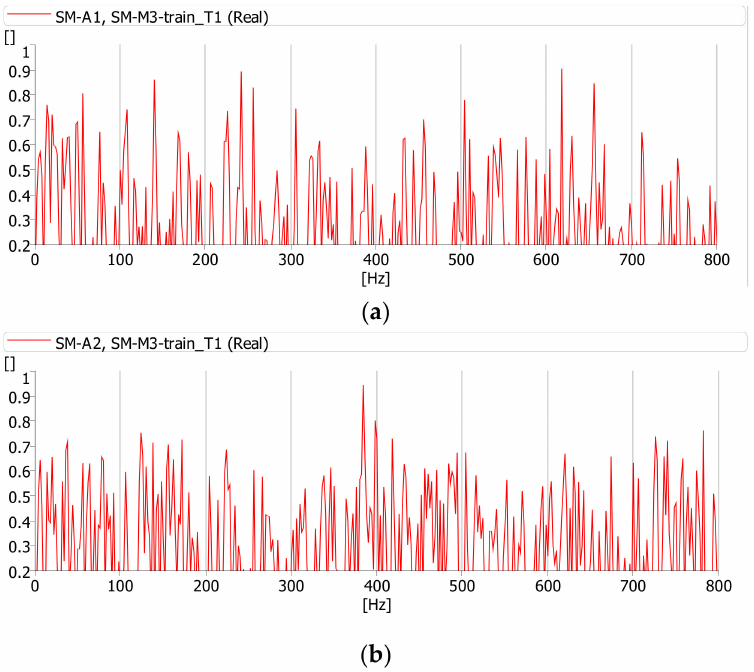
Figure 12. Coherence function between acoustic pressure at point M3 and: ( a ) vibrations at point A1 (deck slab), ( b ) vibrations at point A2 (girder web) during the passage of a cargo train (T1).